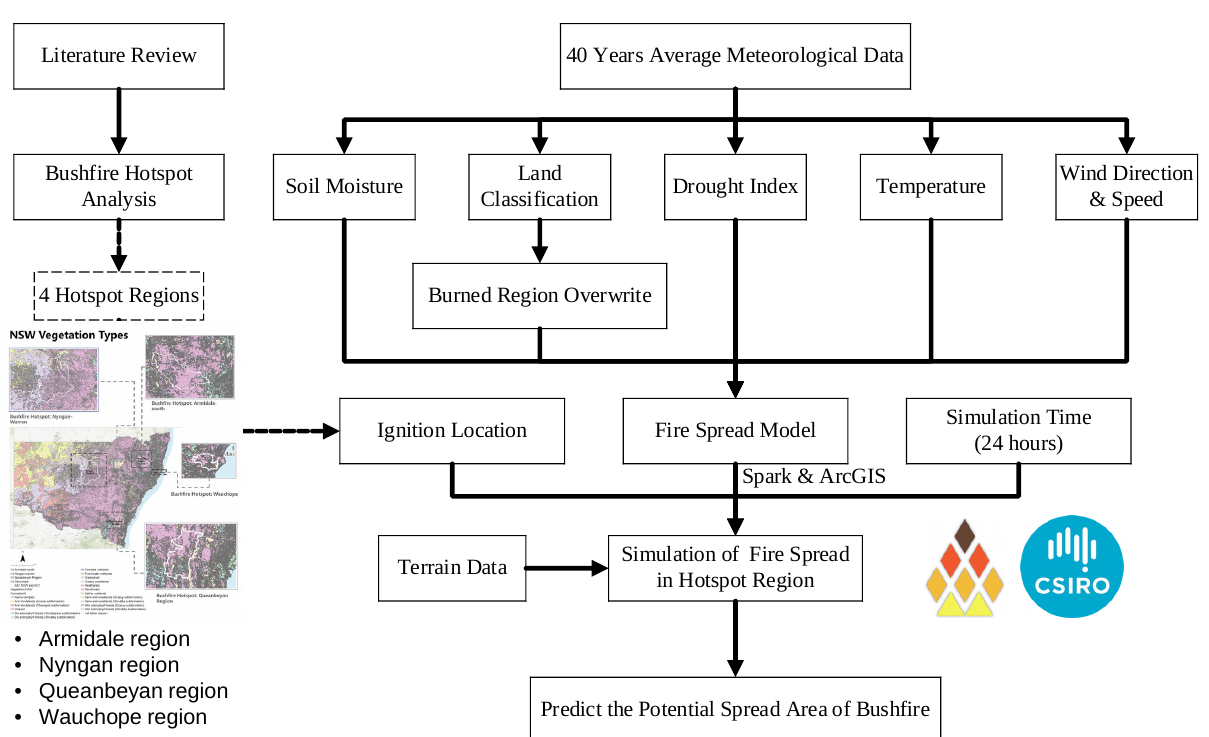
Figure 3. The schematic of bushfire predictions based on Spark.